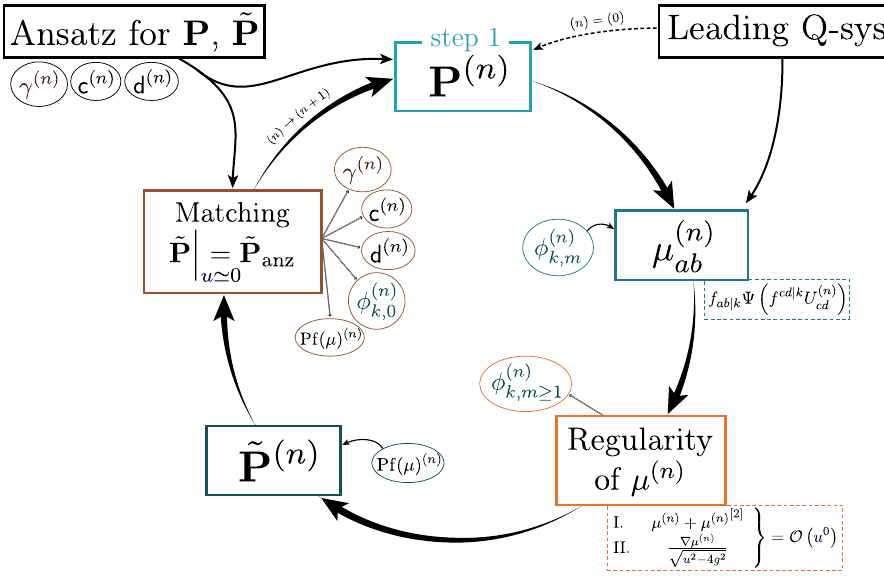
Figure 7 . An overview of the (cid:12)ve steps in the perturbative algorithm. step 1, step 2 and step 4 introduce constants while they are (cid:12)xed in step 3 and step